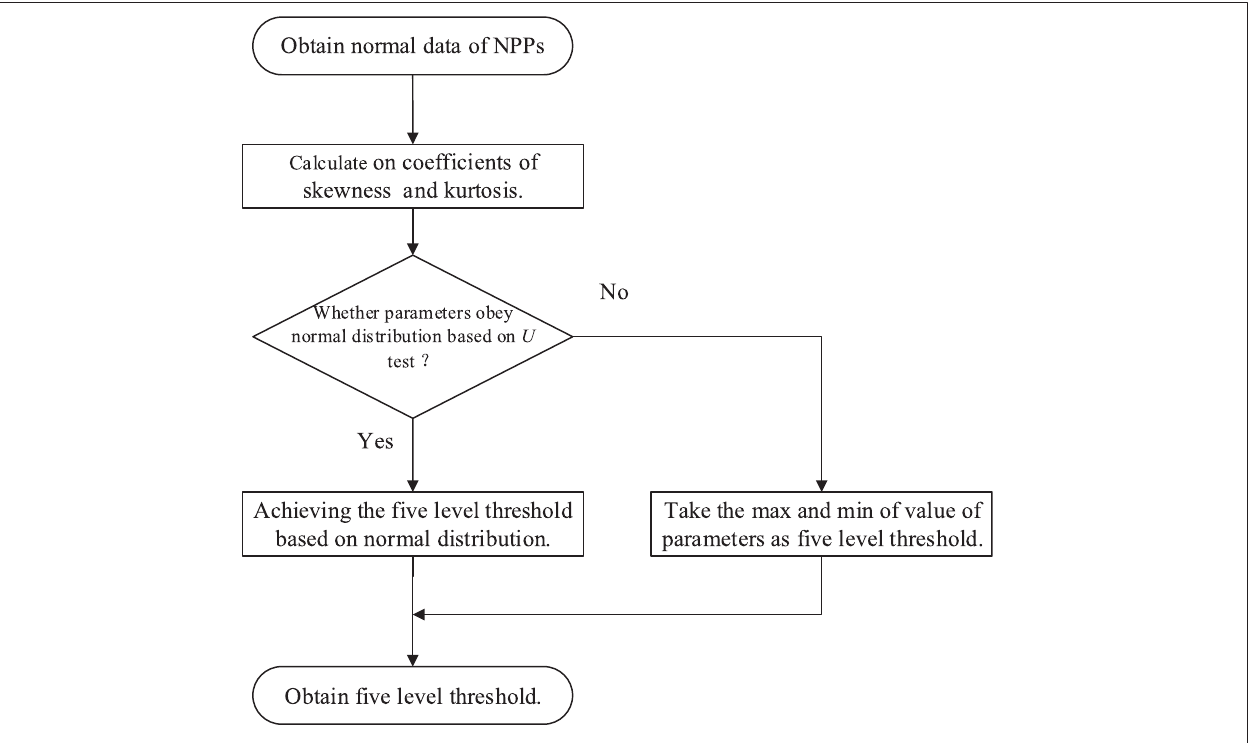
FIGURE 5 | Flow chart for calculation of fi ve-level